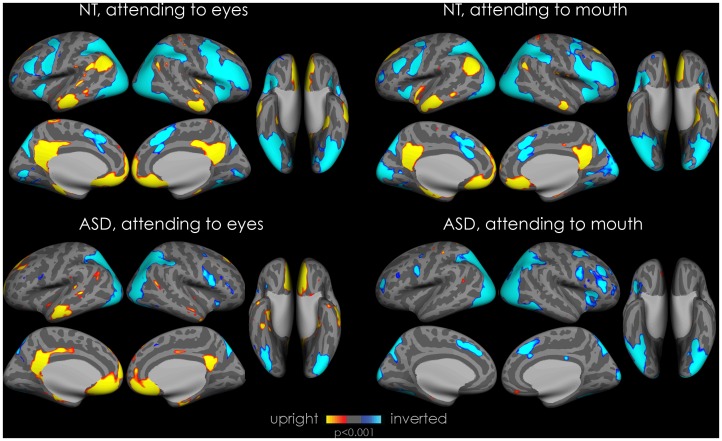
Cortical activation for within-group whole brain analysis.Statistical maps of differences in fMRI activation for each group for each condition. Statistical maps are displayed on the inflated cortical surface of the template FreeSurfer brain (fsaverage), at p<0.001 uncorrected, for visualization purposes, on the lateral, medial and ventral views of both hemispheres. Regions of greater activation for discrimination between upright thatcherized and normal faces are depicted in yellow to red; those for discrimination of inverted thatcherized faces from normal faces are depicted in cyan to blue. The grey mask covers subcortical regions in which activity cannot be expressed in surface rendering. The two left panels show activation for the condition where participants are attending to the eye-region to perform the task (top panel: NT; bottom panel: ASD). The two right panels show activation for the condition where participants are attending to the mouth-region to perform the task (top panel: NT; bottom panel: ASD).